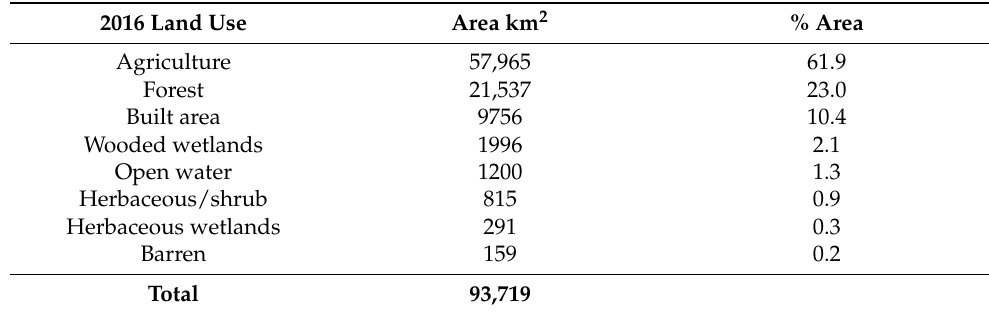
Table 2. Summary of statewide land use of Indiana in